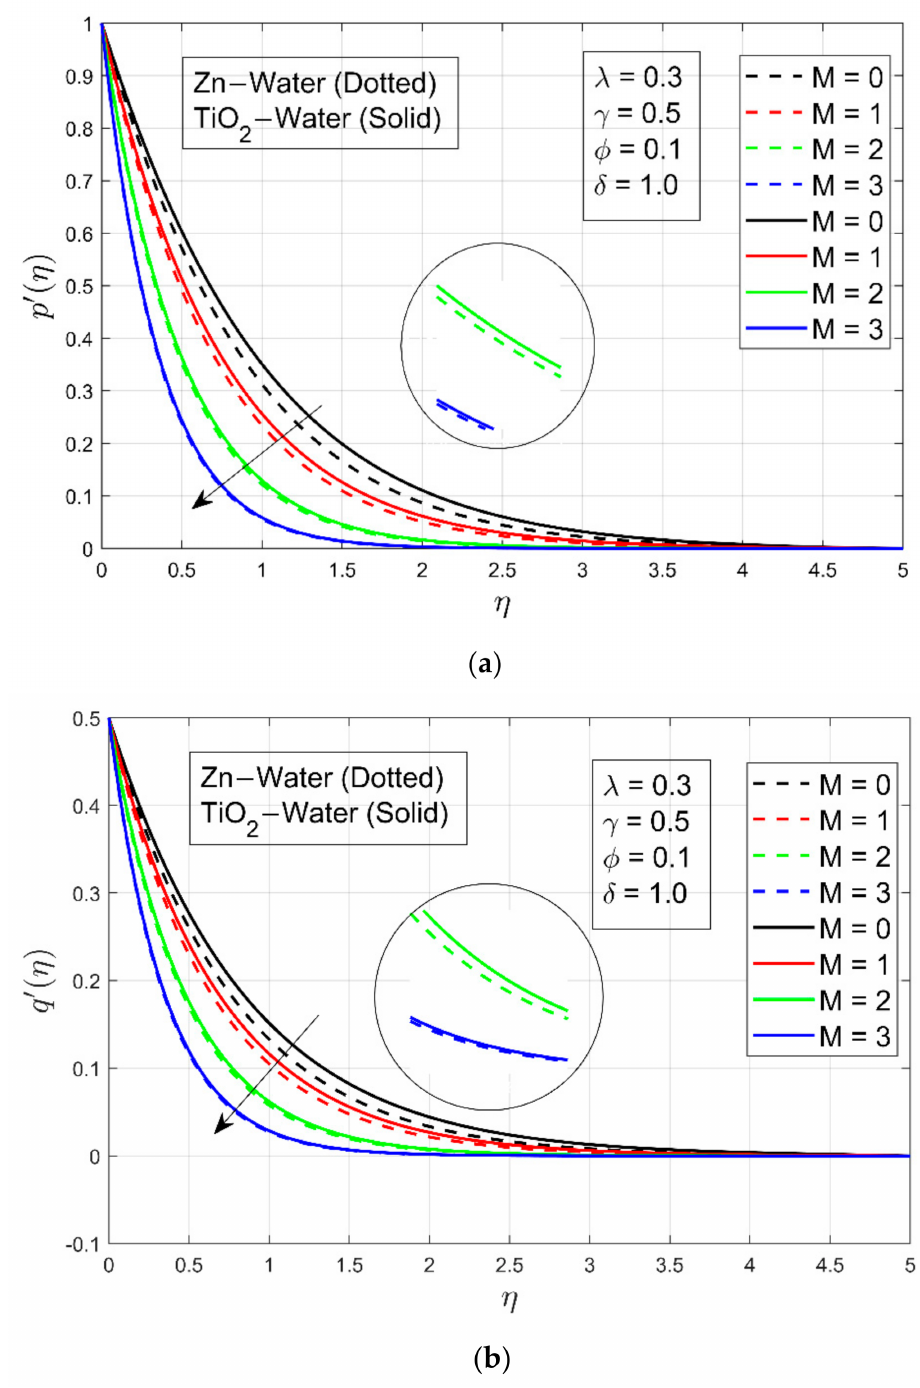
Figure 2. ( a ) The influence of M on p (cid:48) ( η ) , and ( b ) the influence of M on q (cid:48) ( η ) . Moreover, the stimulus of rotation, λ , on velocity constituents p (cid:48) ( η ) and q (cid:48) ( η ) is presented in Figure 3a,b. From Figure 3a,b, it is clear that the velocity profiles ( p (cid:48) ( η ) , q (cid:48) ( η ) ) and boundary layer thickness decay as the rotation parameter, λ , increases. These figures also show that the velocity of the Zn-water nanofluid is always smaller than TiO 2